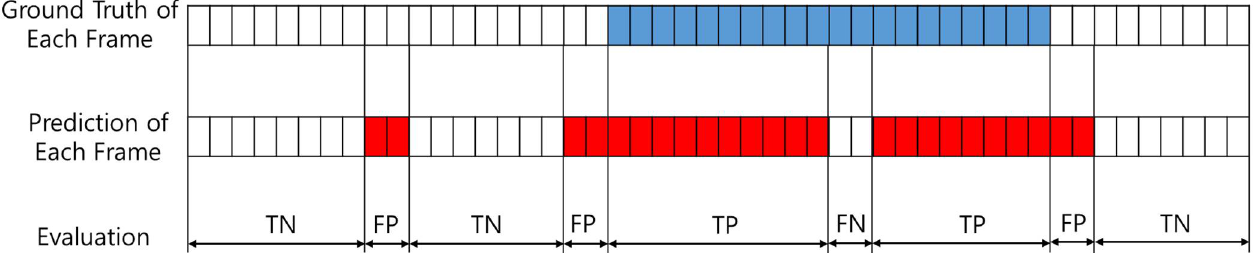
Figure 5. Conceptual diagram of pharyngeal phase recognitions results in test video fluoroscopic swallowing study (VFSS) video clip. Blue boxes mean pharyngeal phase frames labelled by specialists in VFSS video clips. Red boxes mean pharyngeal phase frames predicted by deep CNN model in VFSS video clips. TN: true negative; FP: false positive; TP: true positive; FN: false negative.